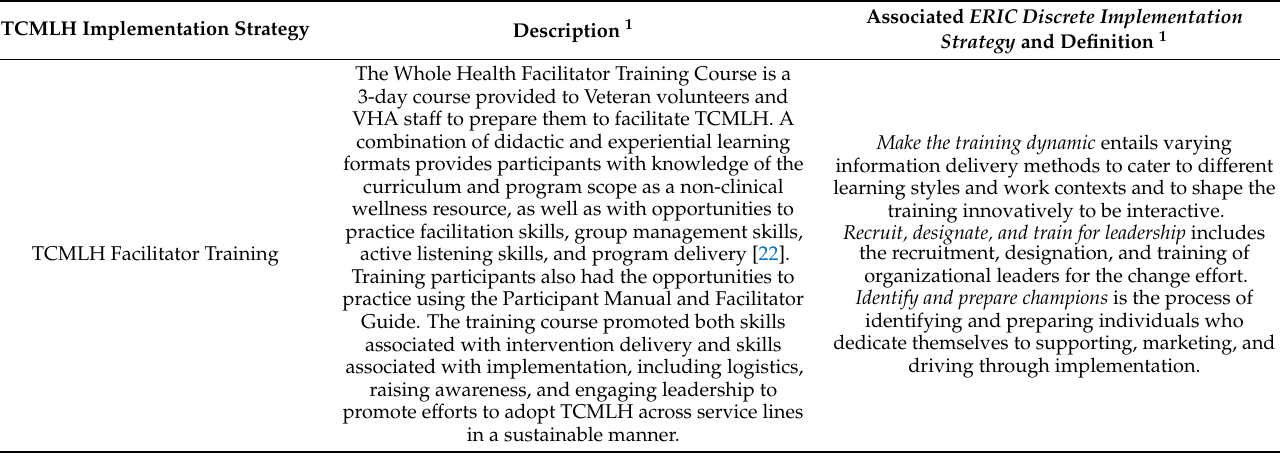
Table 1. Reporting of TCMLH Implementation Strategies Using the Expert Recommendations for Implementing Change